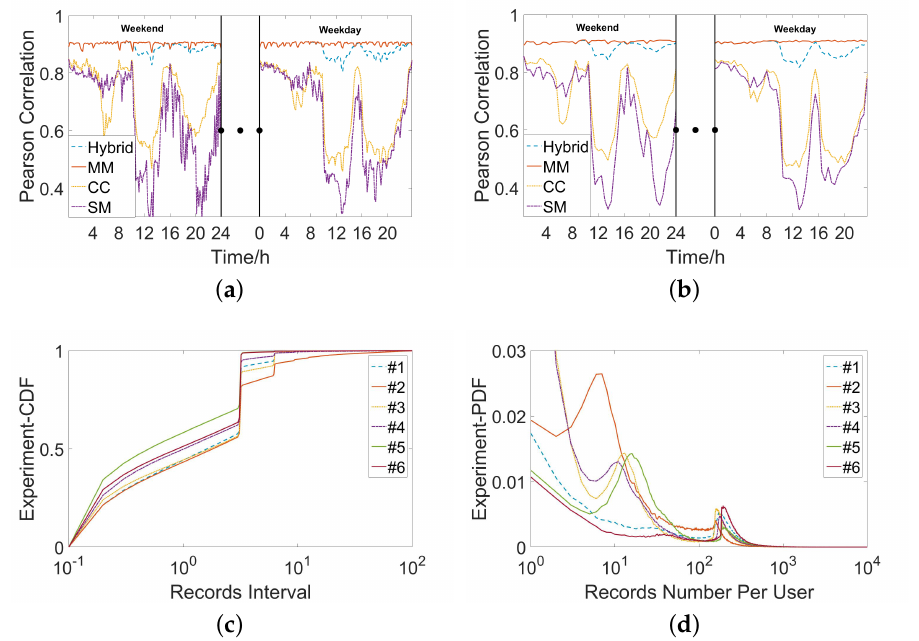
Figure 3. The characteristics of three kinds of data in six cities. The record number of each user is calculated by summing up the number of records belonging to him in the whole data. Here, MM denotes mobility management signals data, SM denotes short message records, CC denotes call detail records, and Hybrid denotes the mixture of three kinds of data. ( a ) With setting the counting time slot as 10 min, the correlation between the mobile phone users and the population among all the regions in Urlumqi; ( b ) With setting the counting time slot as 30 min, the correlation between the users and the population among all the regions in Urlumqi; ( c ) The records interval distribution in 6 cities; ( d ) The records number of single user distribution in 6